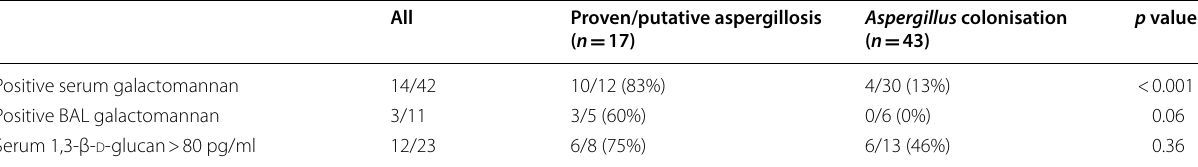
Numbers of patients with a positive measurement/numbers of patients with measurement performed